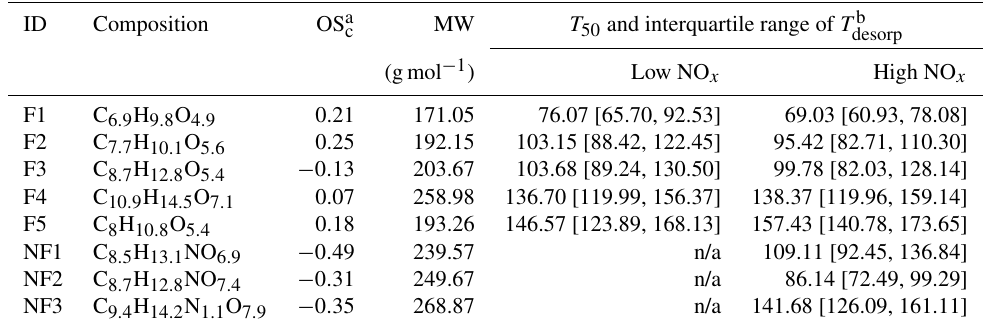
Figure 2. FIGAERO-CIMS sum thermograms (STGs) (a–d) plotted against the desorption temperature ( T desorp ) and the corresponding median desorption temperature ( T 50 ; diamonds) (e) for the high NO x case under low RH ( < 7%RH) and high RH (80%RH) conditions. CHO compounds and ONs are indicated by C x H y O z and C x H y N 1 , 2 O z , respectively. (a–d) The solid black lines indicate the total signals of STGs, with the green and yellow areas marking the contributions of C x H y O z and C x H y N 1 , 2 O z to the STGs, respectively. The gray-striped areas represent the differences in STGs between fresh and RTC stages. The color bands on the abscissa indicate volatility classes. Note that we presented the STGs of RTC stages after accounting for changes in the average VFR (VFR avg ) between fresh and RTC stages during the FIGAERO sample time. Table 2. Summary of CHO factors in the α -pinene SOA particle formed under low NO x and high NO x conditions in the